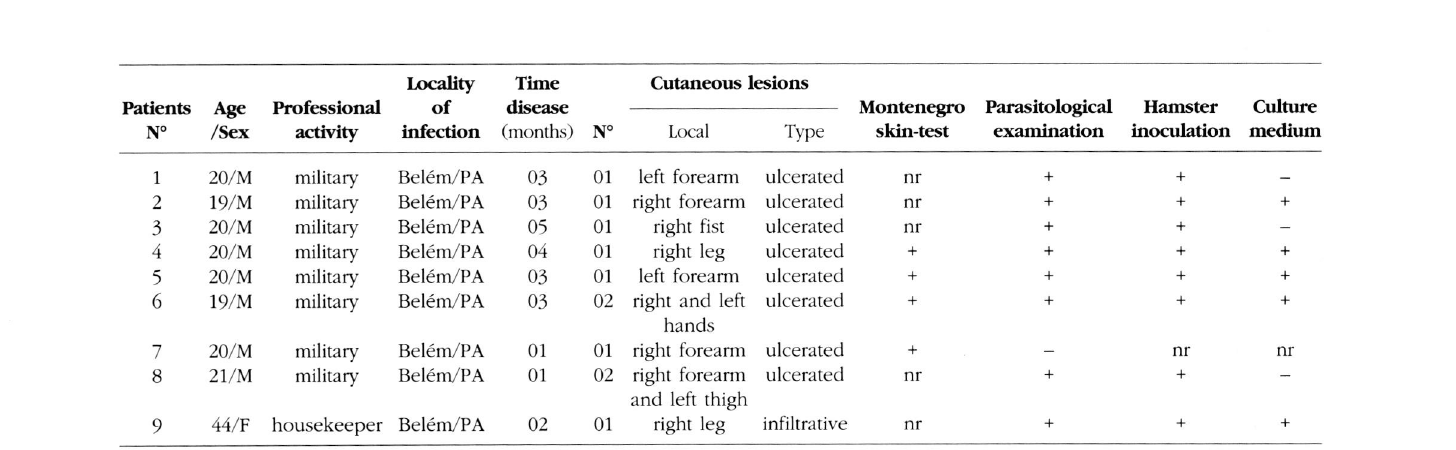
Table I. - The clinical and laboratorial observations on the nine patients suffering from cutaneous leishmaniasis caused by L. (V.) linden­ bergi n. sp., Belem, Para, Brazil, nr = not made.